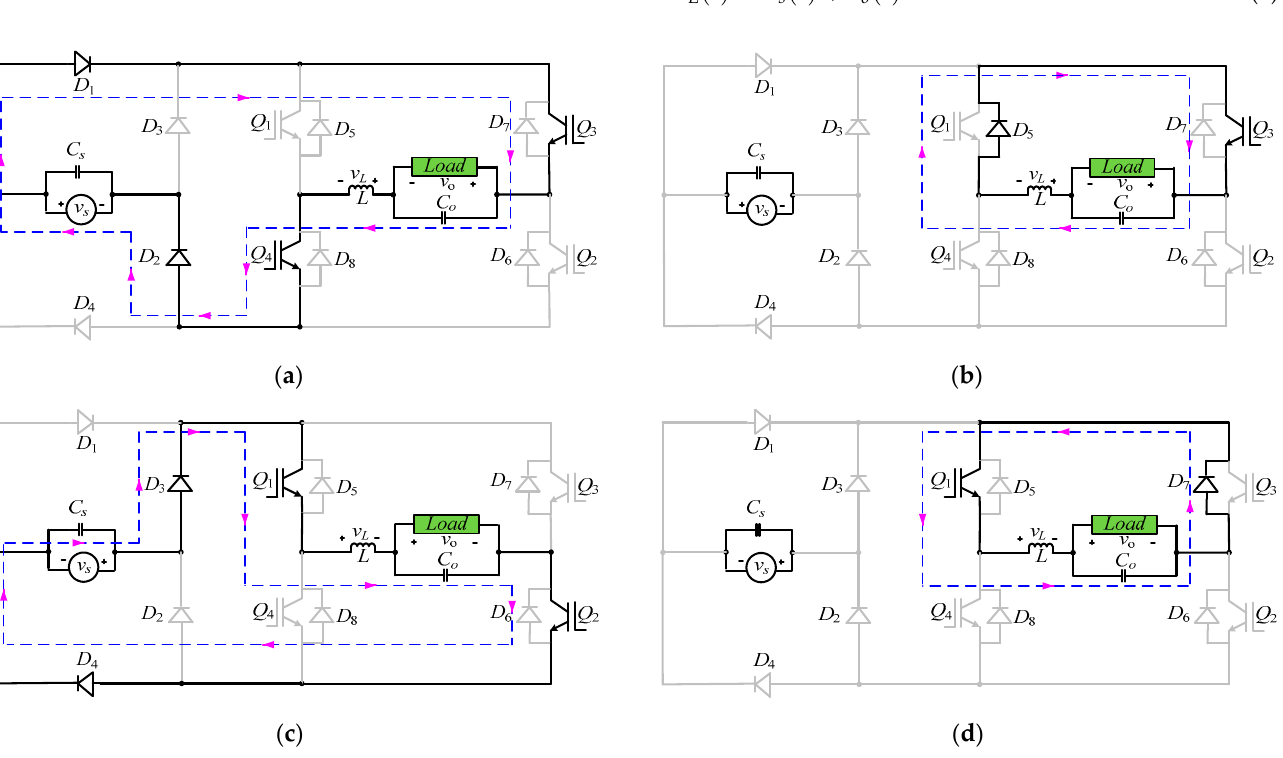
Figure 5. Equivalent power transfer circuits for inverting voltage buck operation: ( a , b ) for mode III; ( c , d ) for mode IV.